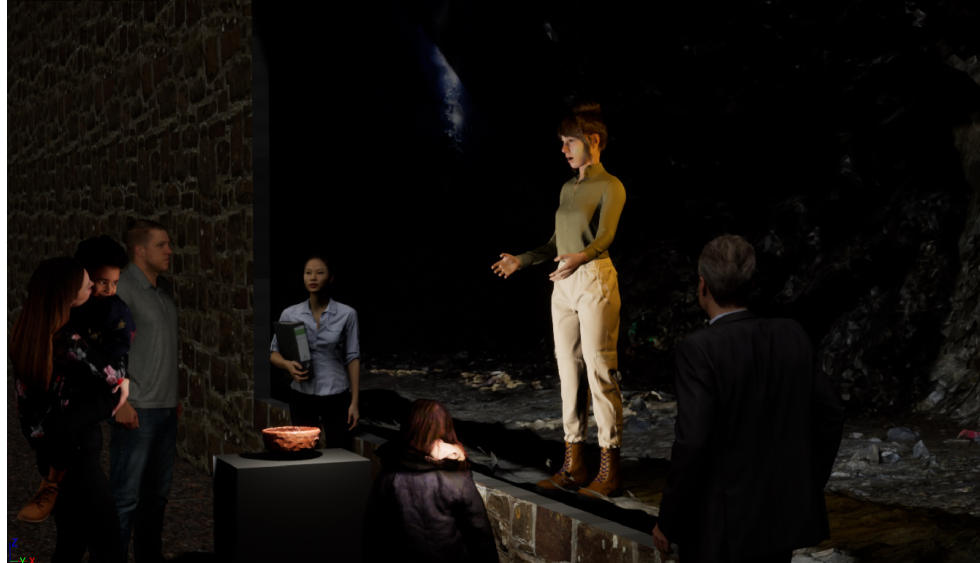
Figure 6. Simulation of visitors listening to the projected Avatar during the